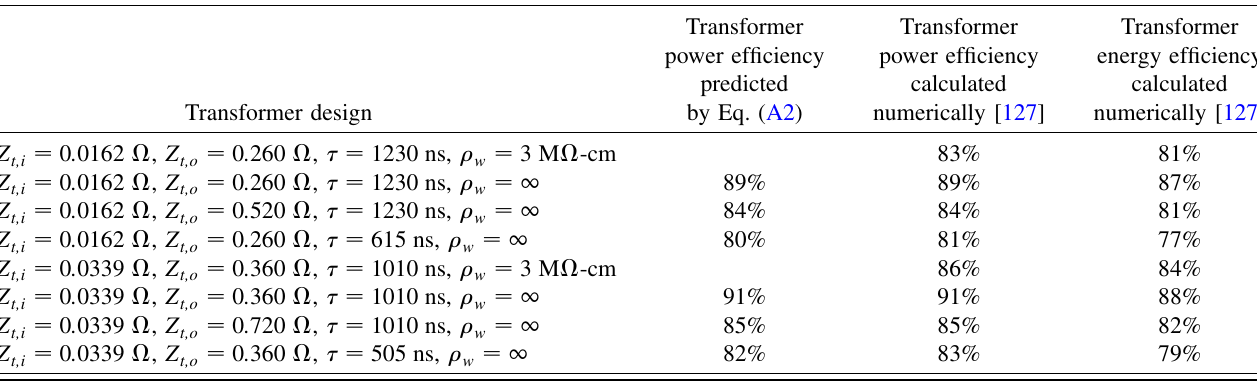
TABLE III. Power and energy efficiencies of several transmission-line transformers with exponential impedance profiles. In each , and that the transformer is terminated in a case it is assumed that the pulse generator that drives the transformer has impedance Z t; i load with impedance Z . Hence the efficiencies given below are valid only under these idealized conditions. All the calculations t; o (cid:4) 1 : 40 (cid:3) 10 7 s (cid:7) 1 . The efficiencies are given for assume that the dominant angular frequency of the forward-going voltage pulse ! v different impedance ratios, transformer lengths, and water resistivities. The power efficiencies calculated analytically are given by Eq. (A2); the numerical efficiencies are obtained using the SCREAMER circuit code [127]. The transformers described in the 1st and 5th rows are those assumed for the Marx- and LTD-based accelerators described in Secs. III A and VA, respectively. [No analytic (cid:4) 1 .] For each of the six cases that assume predictions are given for these two cases since Eq. (A2) assumes the water resistivity (cid:4) w (cid:4) 1 , the analytic power efficiency is in reasonable agreement with the numerical (cid:4) w